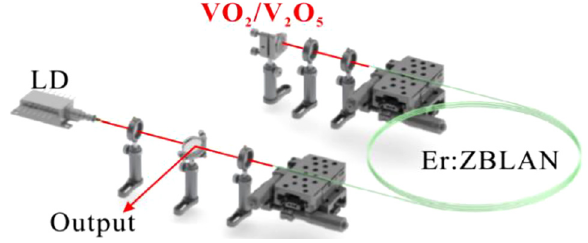
Figure 8: Experimental setup of the 2.8 μ m Q-switched fi ber laser.